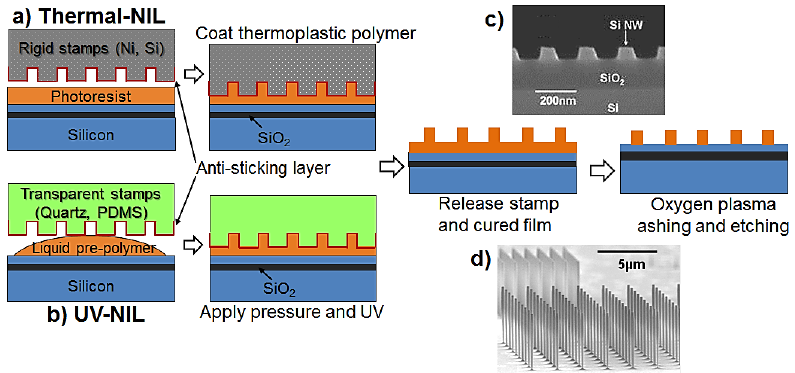
Figure 3. Illustration of SiNWs fabrication processes based on ( a ) T ‐ NIL and ( b ) UV ‐ NIL. Typical horizontal ( c ) and vertical SiNWs ( d ) fabricated by nanoimprinting techniques. Reprinted with permission from Ref. [43], Copyright (2006), AIP and Ref. [7], Copyright (2010), ACS, respectively.